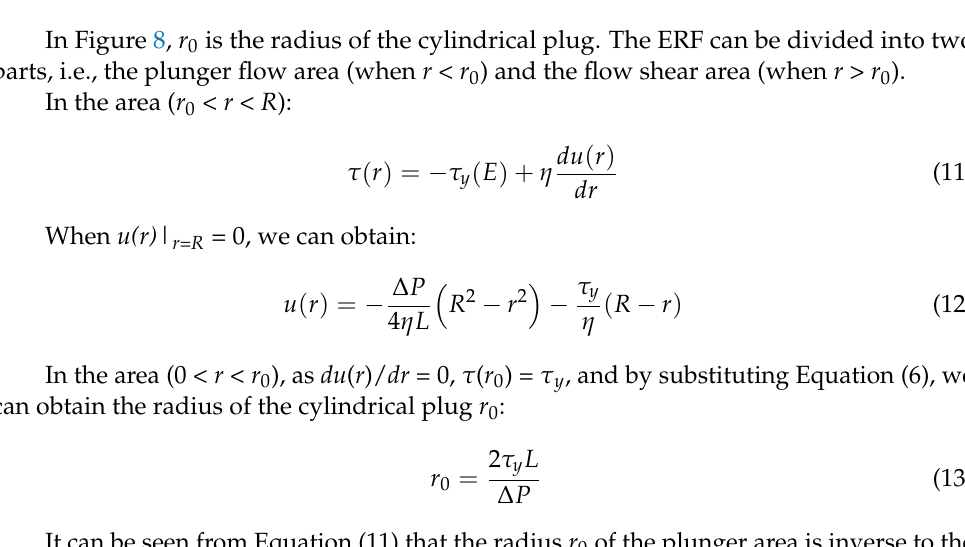
Figure 8. Velocity distribution of the ERF in the microchanne